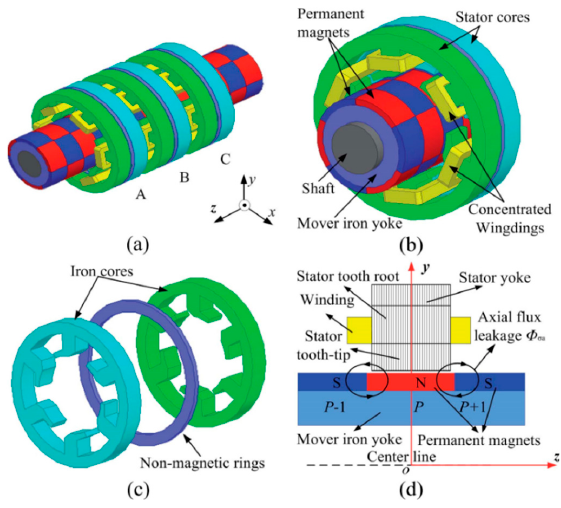
Figure 10. Structure of the staggered-tooth transverse flux PMLEM (TFPMLEM) [16]. ( a ) Overall structure; ( b ) One phase of machine; ( c ) Stator cores and nonmagnetic ring; ( d ) Side view of machine with one stator core.